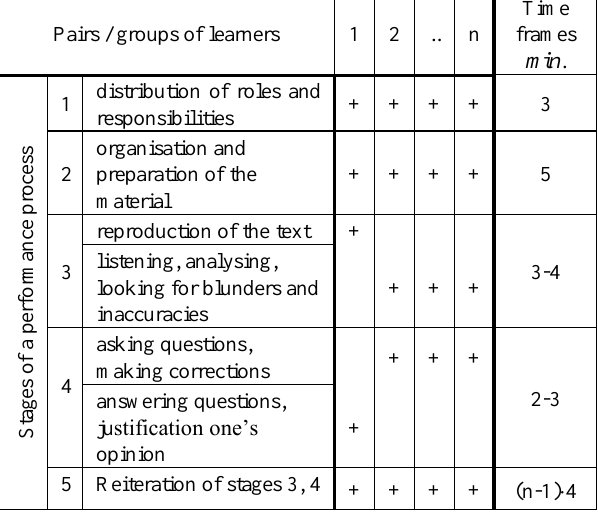
Table 3. Stages and time frames of a text reproduction /